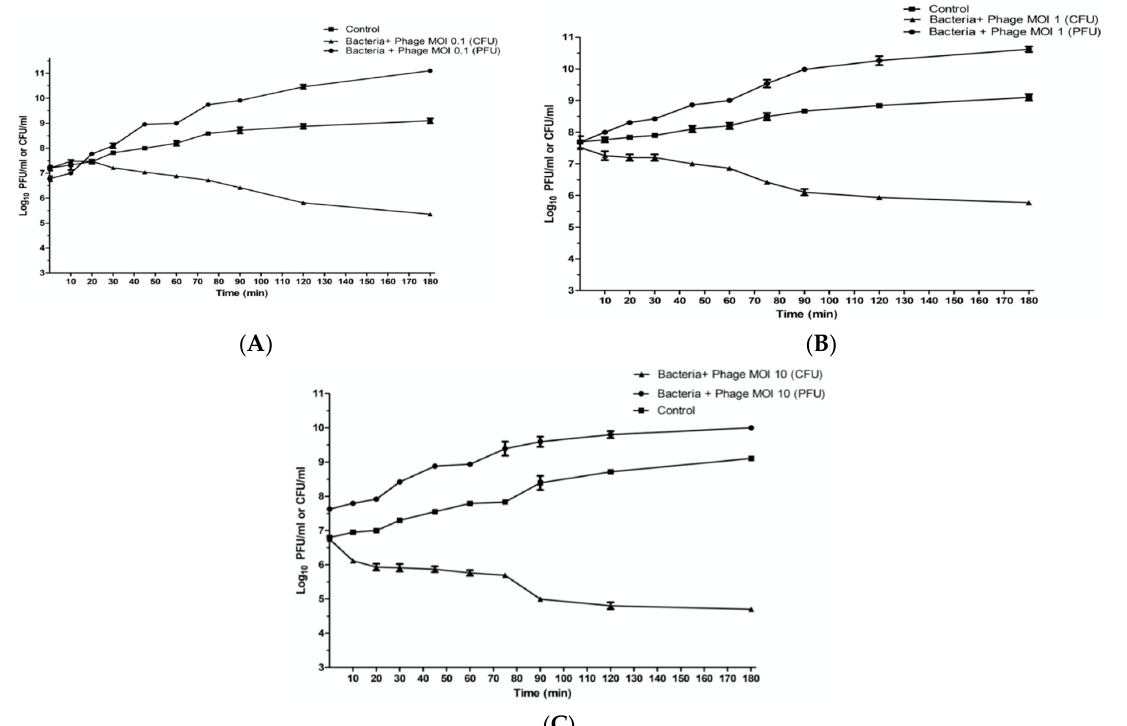
Figure 4. These plots represent the in vitro activity of phage ZCKP8 at 37 °C. These panels show bacterial counts and phage titers of K. pneumoniae KP/15 infected with ZCKP8 at ( A ) MOI of 0.1; ( B ) MOI of 1; ( C ) MOI of 10. MOI: Multiplicity of infection; CFU: Colony-forming unit; PFU: Plaque forming unit.